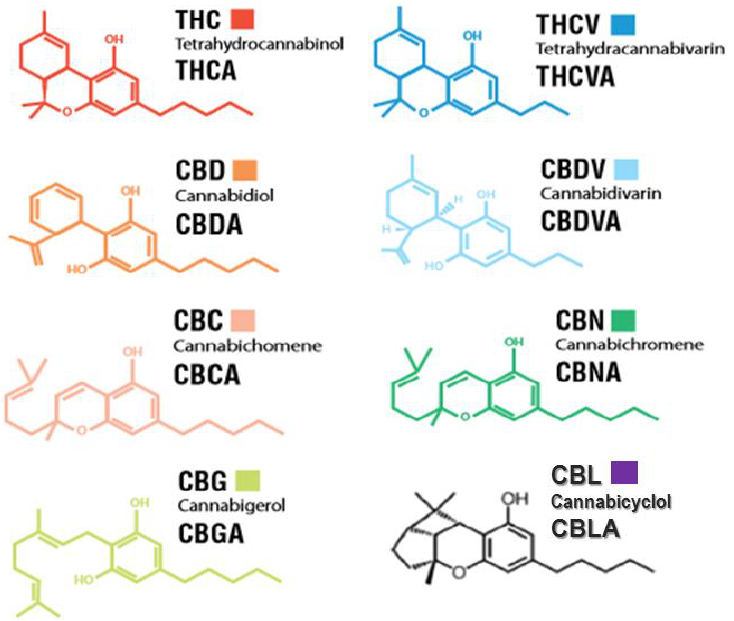
Figure 1. Natural important cannabinoids and their structure.